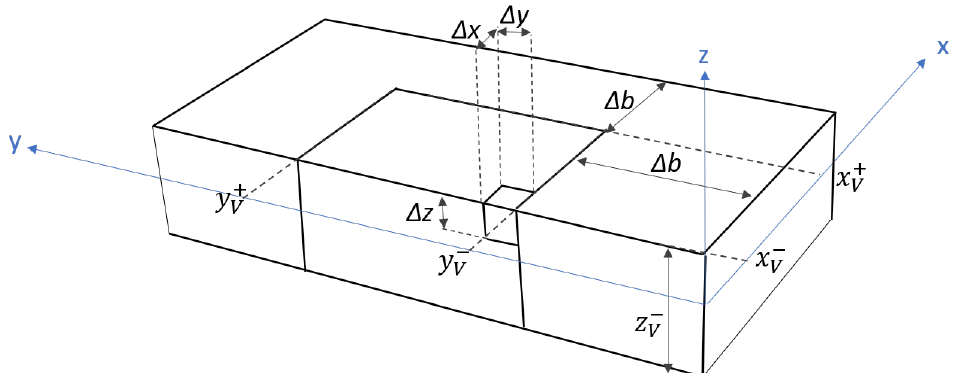
Figure 1. Schematic representation of the parameters defining the 3D model for the gravity inversion discussed in this